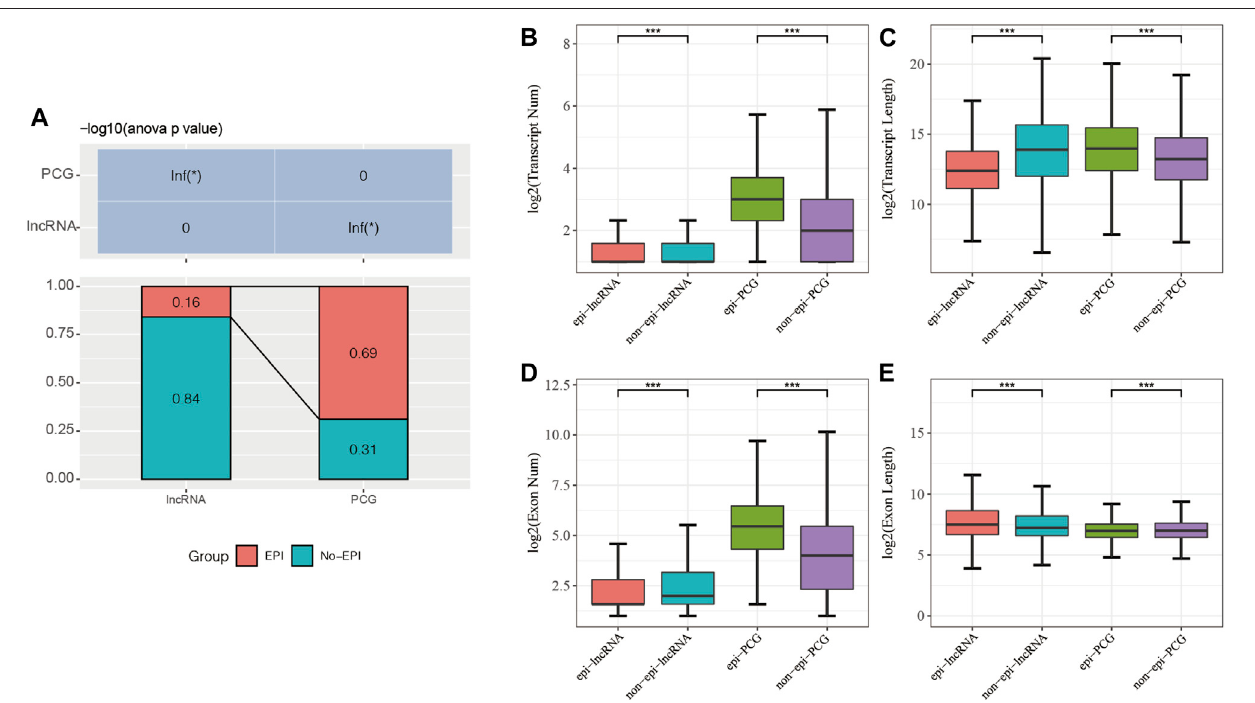
FIGURE 1 | (A) Percentage of epi-lncRNAs and epi-PCGs for all lncRNAs and PCGs in the genome; (B – E) : Comparison of the genomic characteristics of epigenetically dysregulated lncRNAs/PCGs and non-epigenetically dysregulated lncRNAs/PCGs.